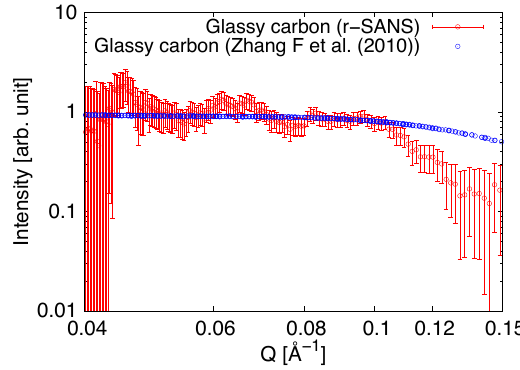
Fig. 3. Scattering intensity of a glassy carbon sample